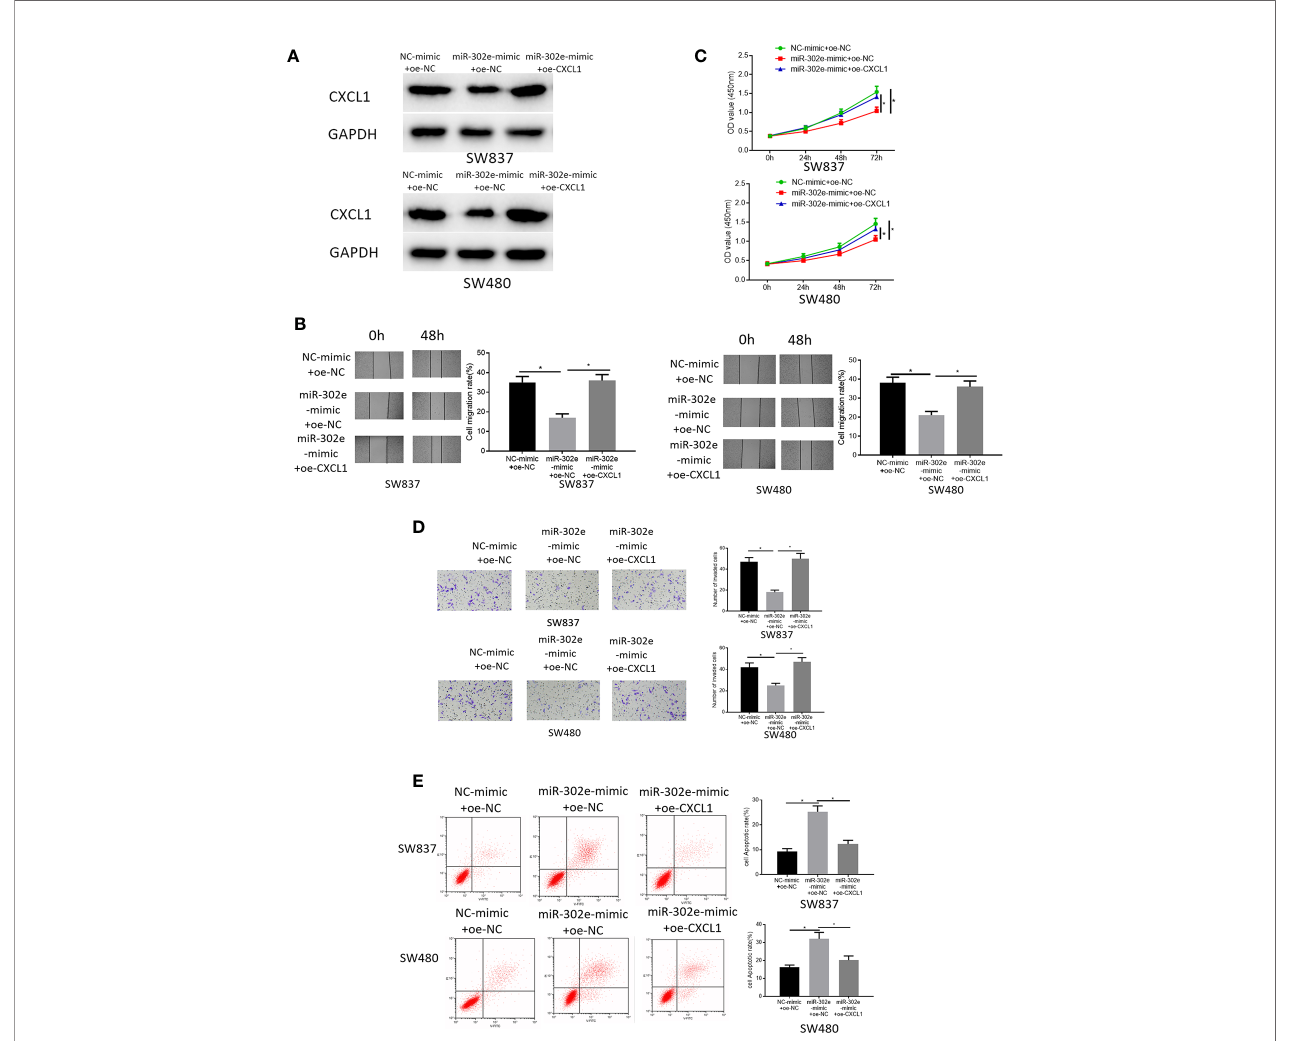
FIGURE 5 | miR-302e targets CXCL1 to inhibit cell proliferation, migration, invasion and promote cell apoptosis of CRC. Cells were classi fi ed into NC-mimic+oe-NC, miR-302e-mimic+oe-NC, miR-302e-mimic+oe-CXCL1 groups. (A) Western blot experiment showed the protein expression of CXCL1 in SW873 and SW480 cells in each treatment group, (B) CCK-8, (C) wound healing assay, (D) Transwell invasion assay (100×), and (E) fl ow cytometry showed the proliferation, migration, invasion and apoptosis of SW873 and SW480 cells in each group (* p <